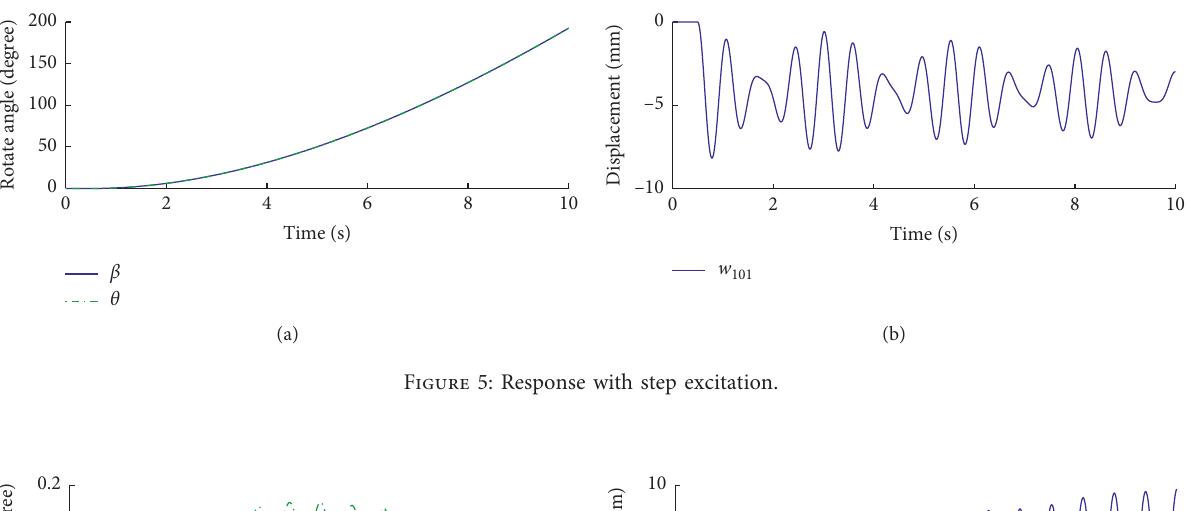
Figure 4: Response with impulse excitation.